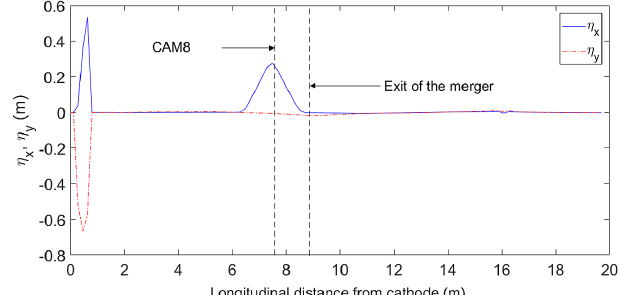
FIG. 9. The horizontal (solid line) and the vertical (dotted- dashed line) dispersion functions from the electron gun up to the exit of the main linac cavities for the Gaussian with σ ¼ 3 . 3 ps core with longitudinal tail t tudinal distribution.